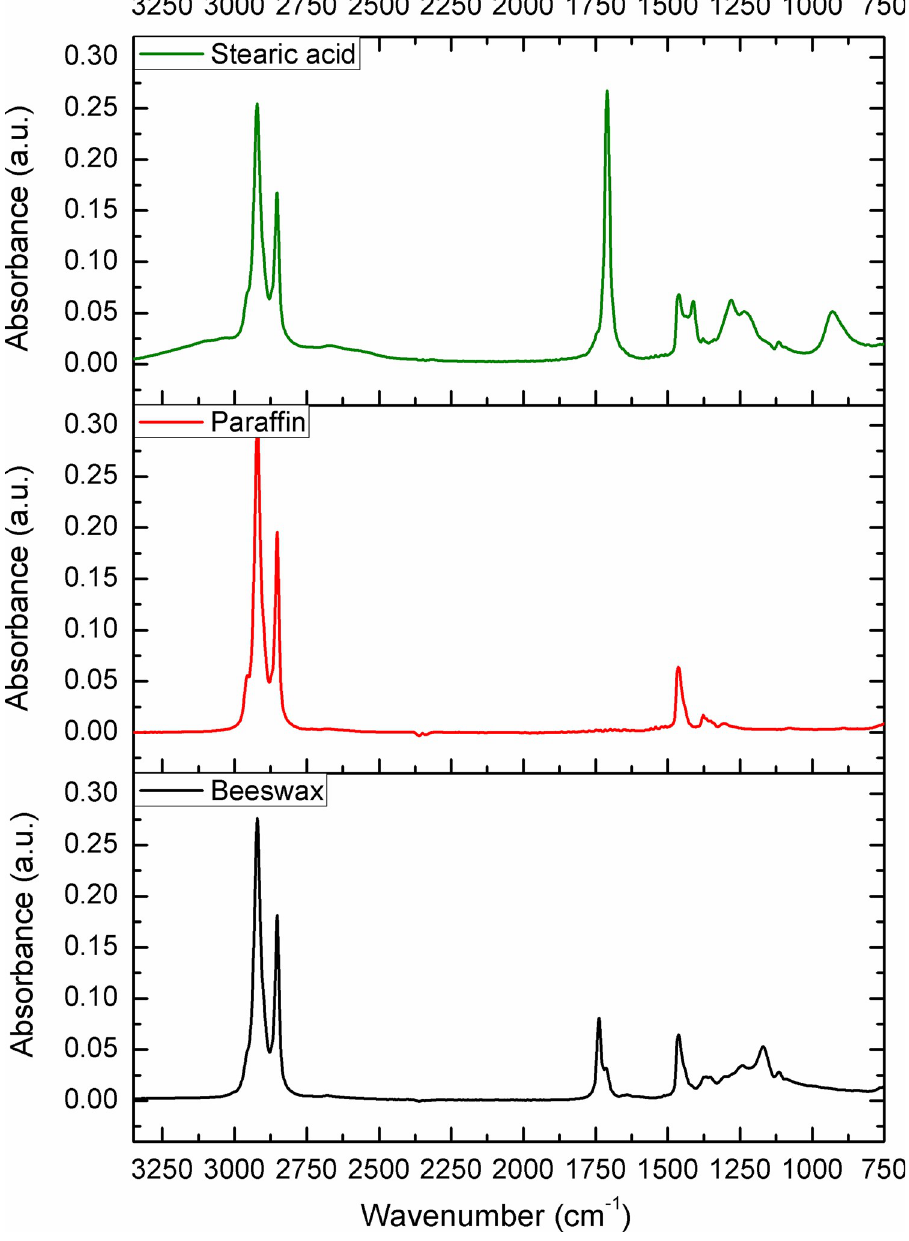
Fig 2. FTIR-ATR spectra of reference standards used for calibration—genuine (pure) beeswax, and adulterants (paraffin— Paraffinum solidum , stearic acid— Acidum stearicum ). Wavenumber, the number of waves per unit distance; cm, centimetre; a.u. is for the absorbance